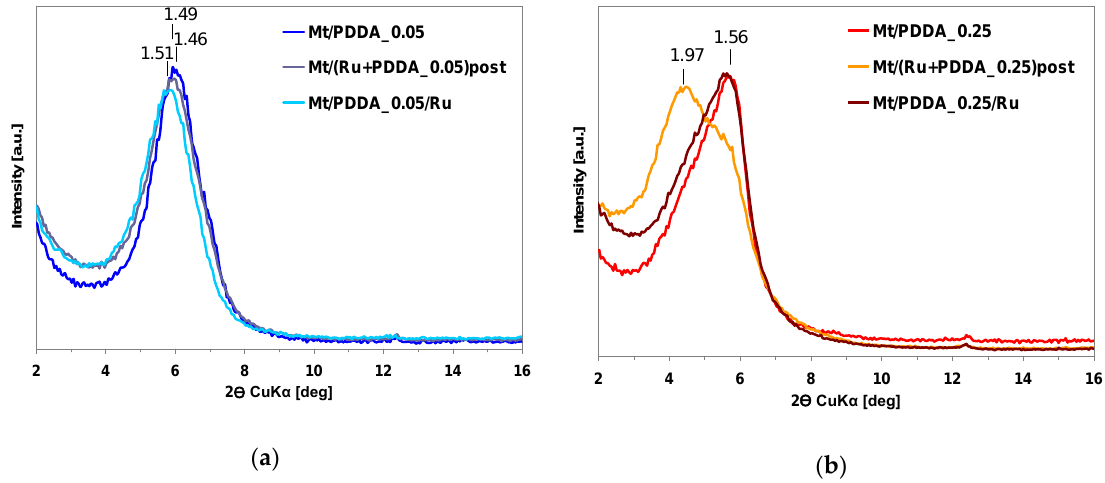
Figure 4. ( a ) Effect of Ru insertion by method II and method III on XRD pattern of Mt intercalated with PDDA cations ( x = 0.05); ( b ) effect of Ru insertion by method II and method III on XRD pattern of Mt intercalated with PDDA cations ( x = 0.25).